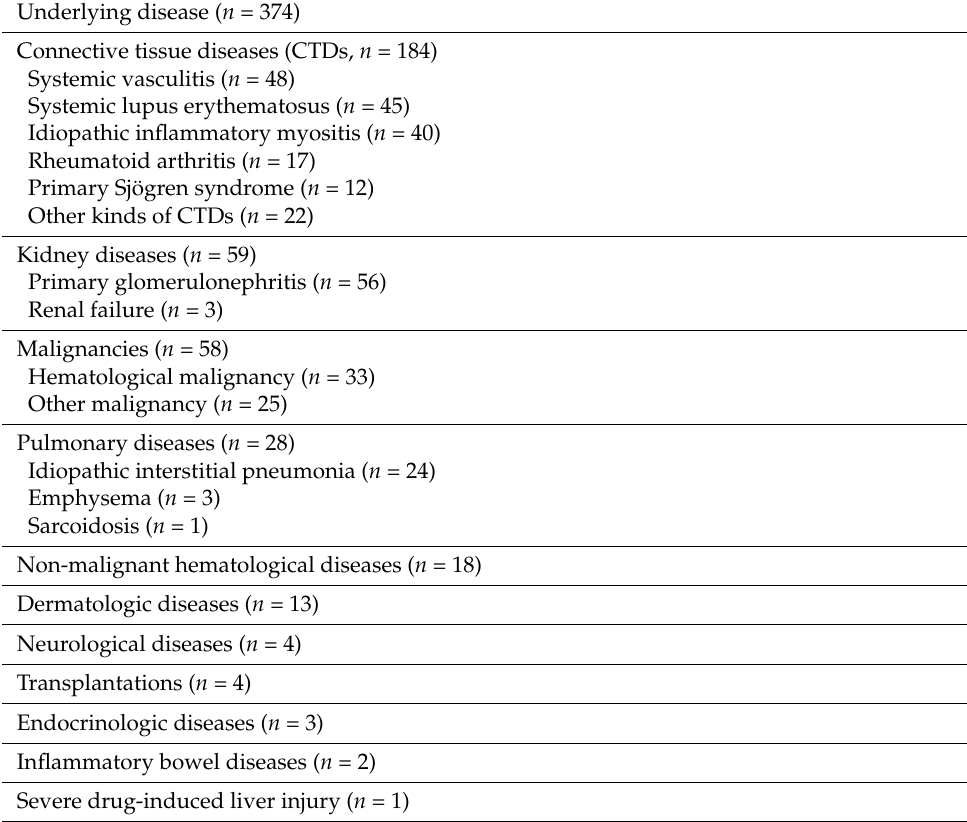
Table 1. The underlying diseases for enrolled PJP